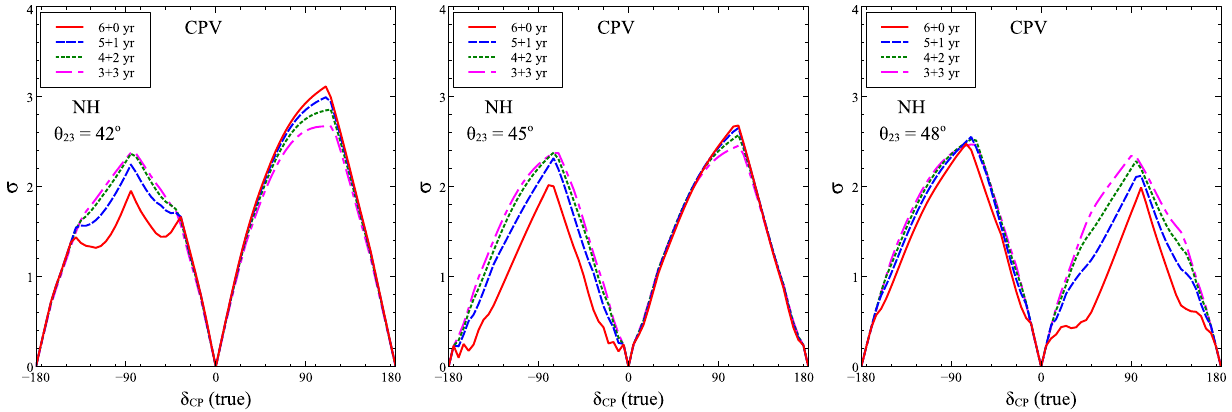
Fig. 7 CPV discovery sensitivity vs δ CP ( true ) for different combinations for neutrino and antineutrino in NH. The left/middle/right panel is for θ = 42 ◦ / 45 ◦ / 48 23